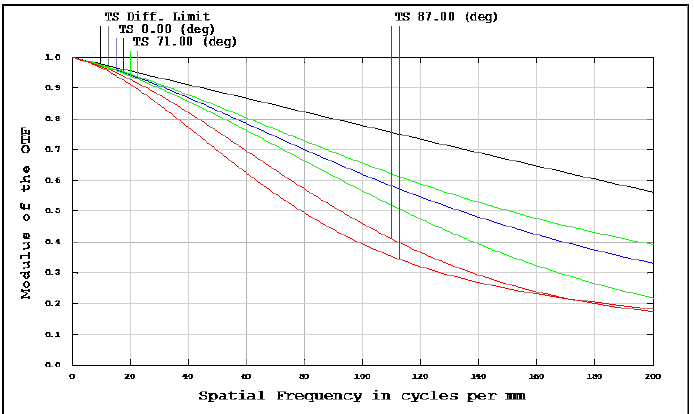
Figure 6. Lateral color of a miniaturized wide-angle fisheye lens combined with an OKP4HT aspherical lens. The blue, green, and red lines represent the wavelengths of 0.4861, 0.5876, and 0.6563 µ m, respectively.